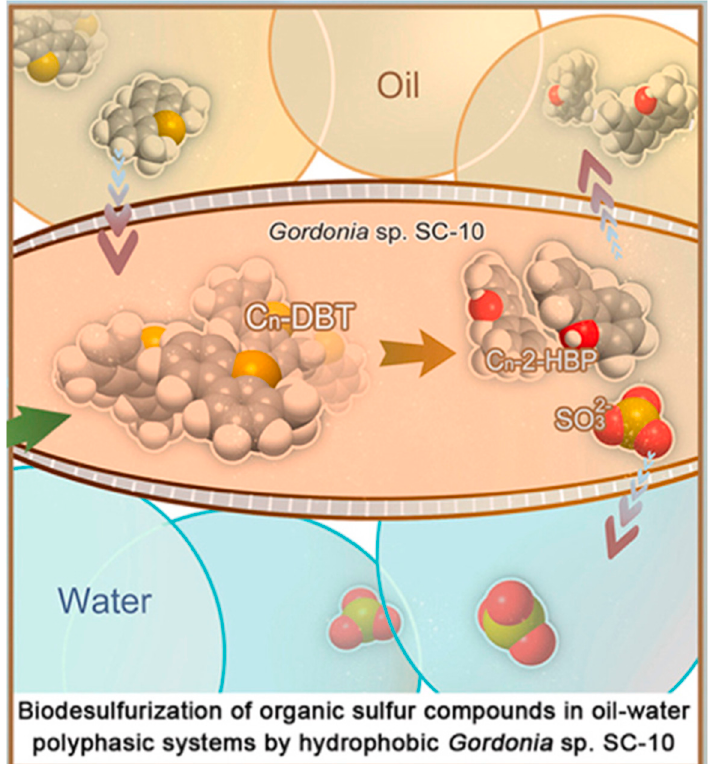
Figure 4. Biodesulfurization process [2]. Permission obtained through Rights Link ® .